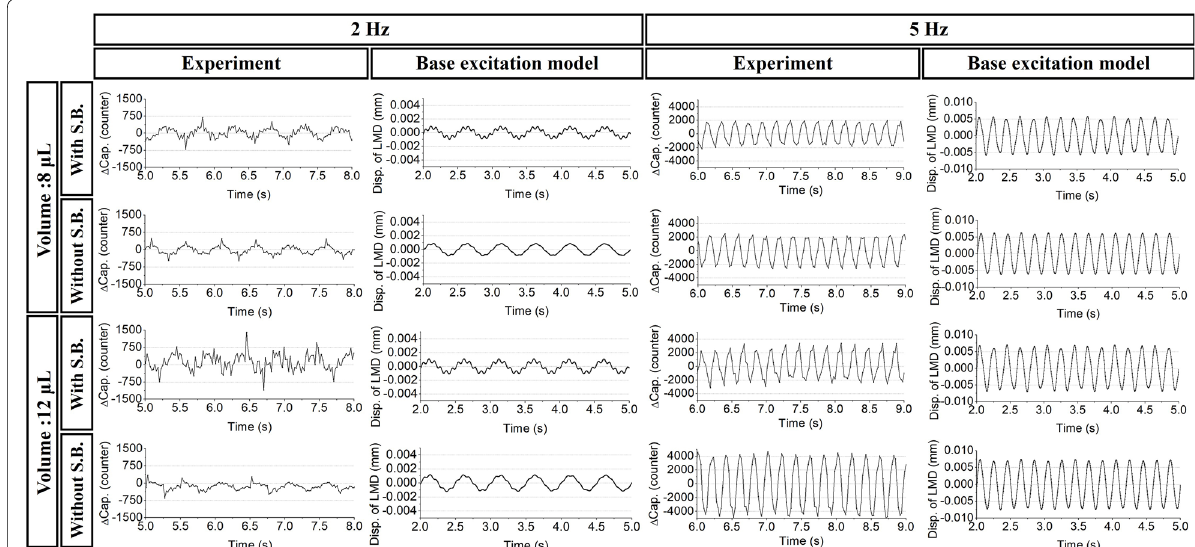
Fig. 3 Comparison of results from the experiment and base excitation mathematical model (S.B.: